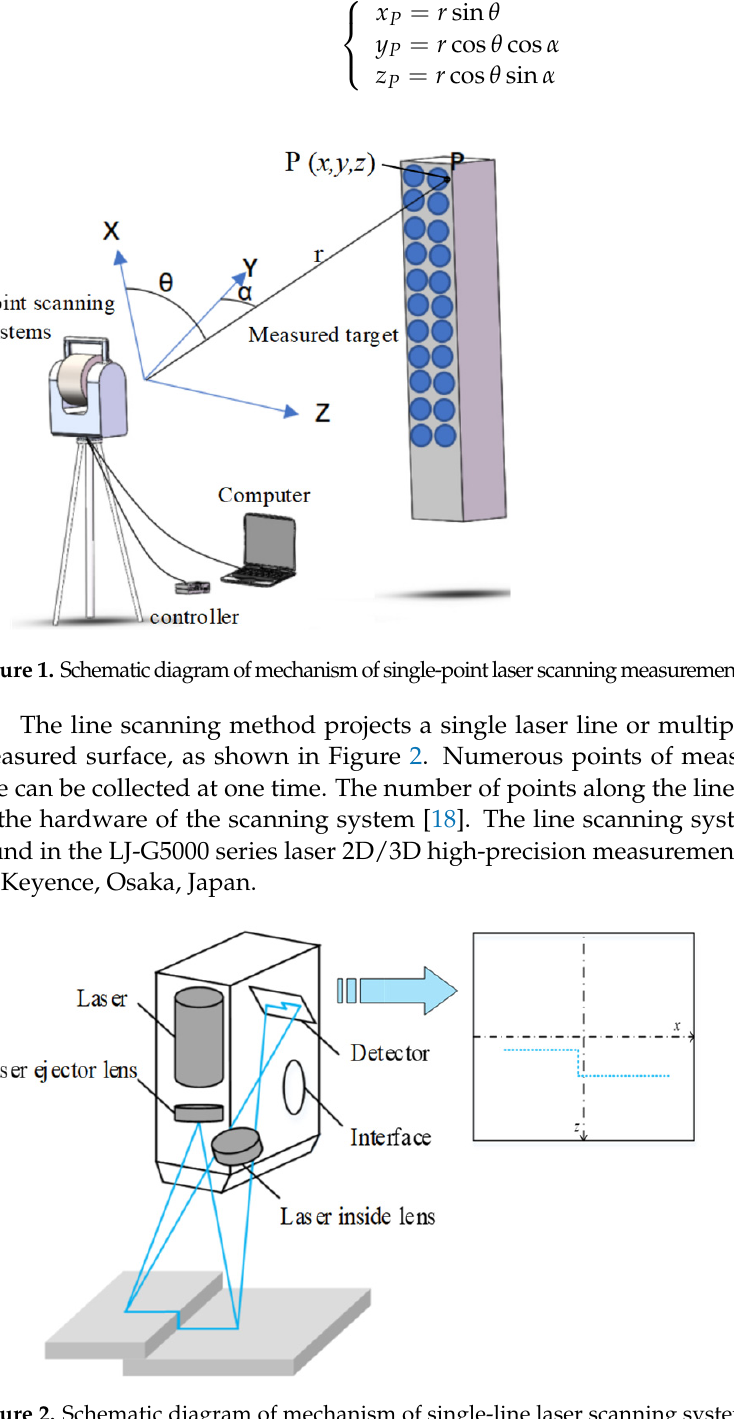
Figure 2. Schematic diagram of mechanism of single-line laser scanning system.